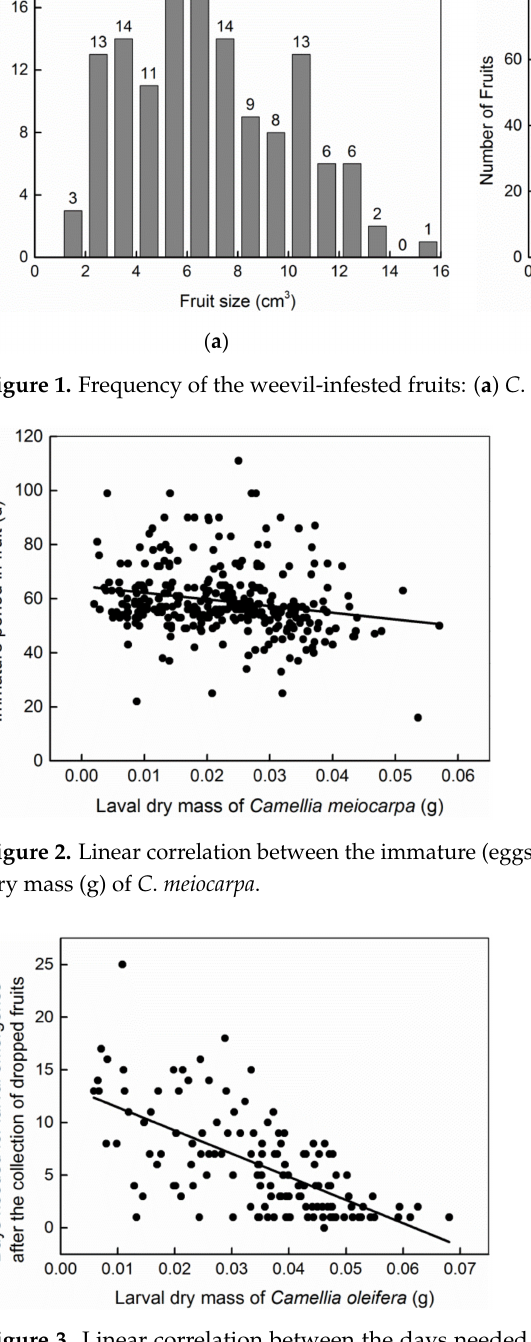
Figure 3. Linear correlation between the days needed for larval emergence after the collection of dropped fruit and the larval dry mass (g) of C . oleifera